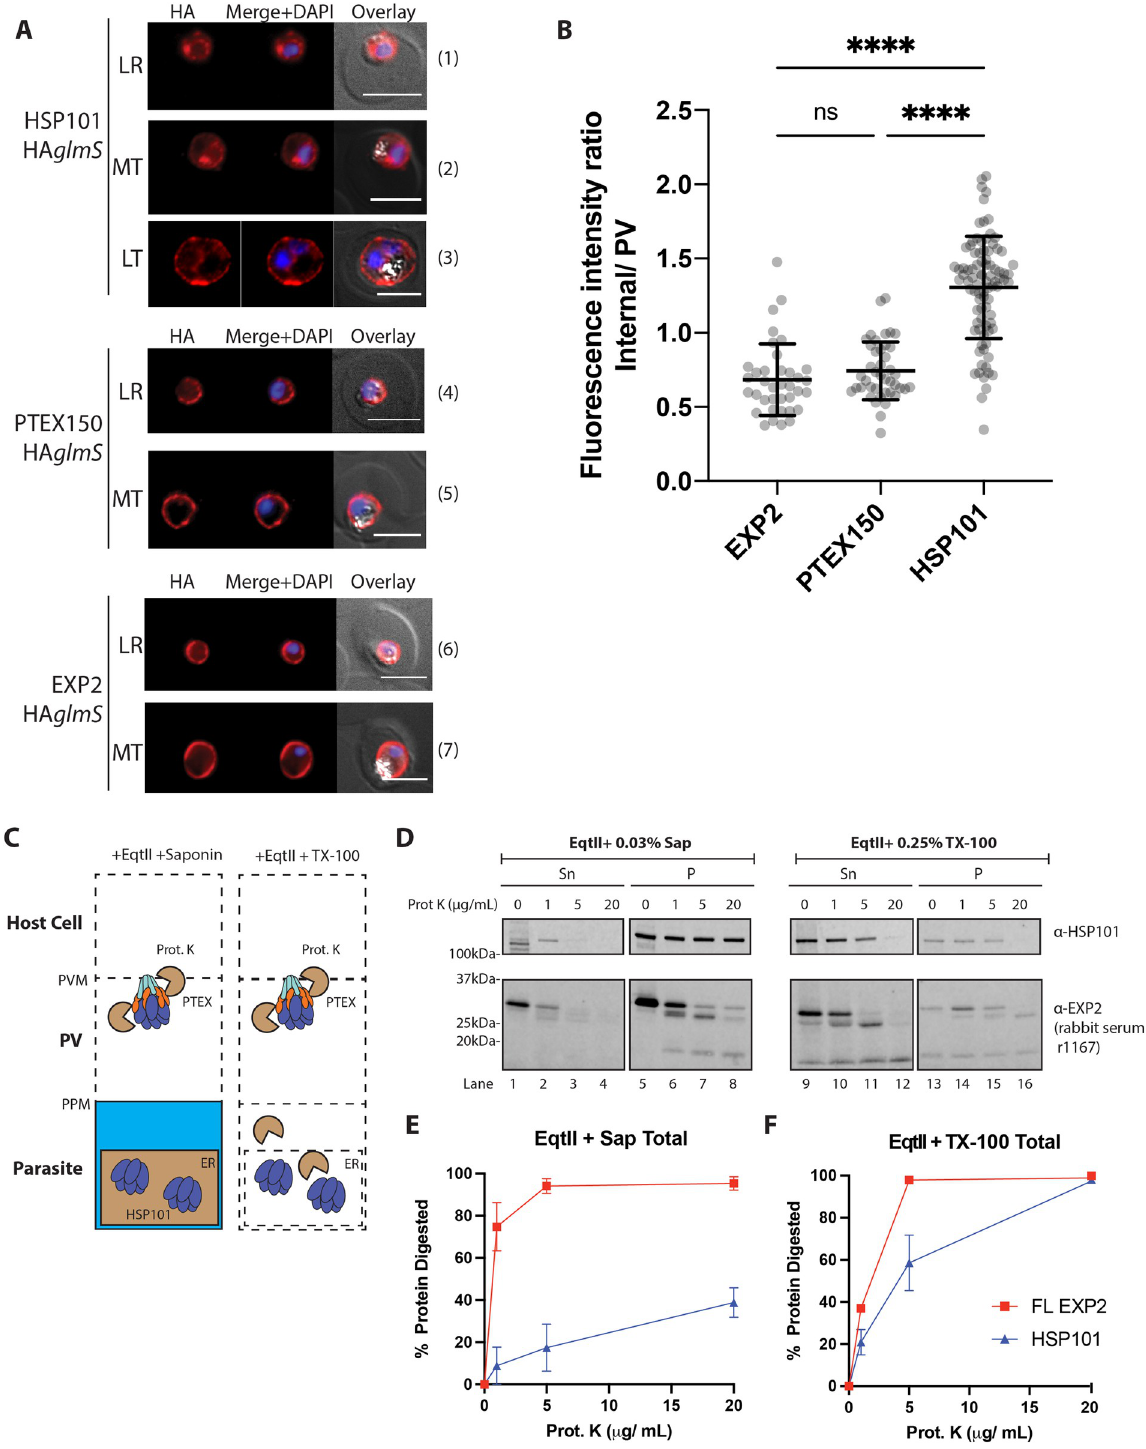
Fig 3. HSP101 exhibits distinct dual localisation inside the parasite and in the parasitophorous vacuole. (A) Representative IFA images of parasites expressing HSP101-HA, EXP2-HA, or PTEX150-HA. Parasites were labelled with anti-HA IgG and nuclei were stained with DAPI. LR, Late ring stage. MT, Mid trophozoite stage. LT, Late trophozoite stage. Scale bar, 5 μ m. (B) Graph of the ratios of internal parasite signal over PV signal for each cell line indicates HSP101-HA exhibits a comparatively greater internal signal than the other PTEX proteins. Data were pooled from at least two biological replicates, with > 20 mid trophozoites (MT) parasites measured for each line. Statistical significances